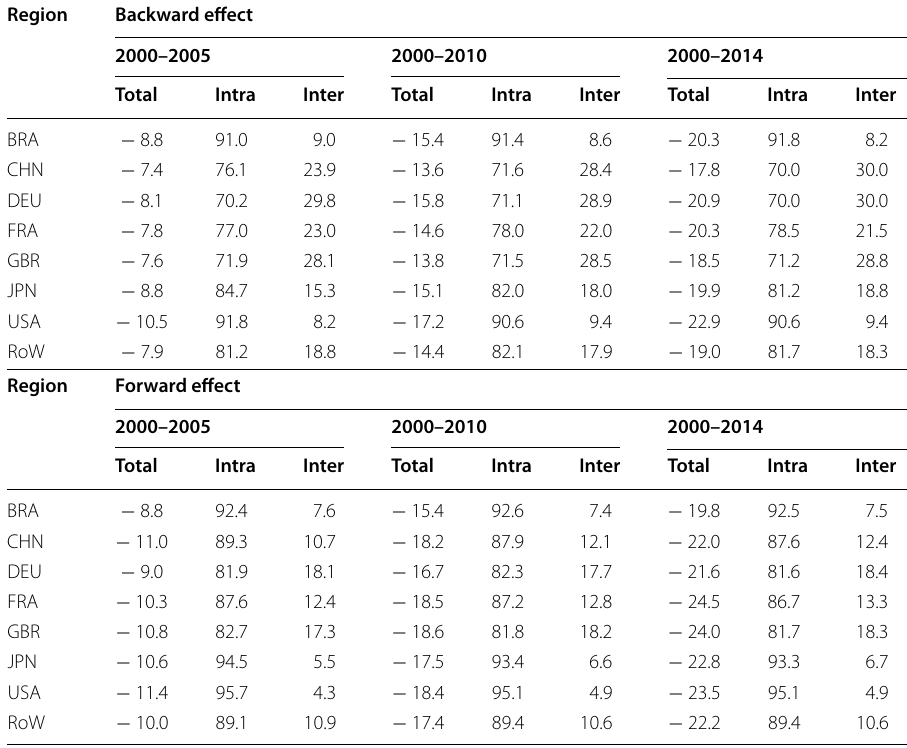
Source: research results